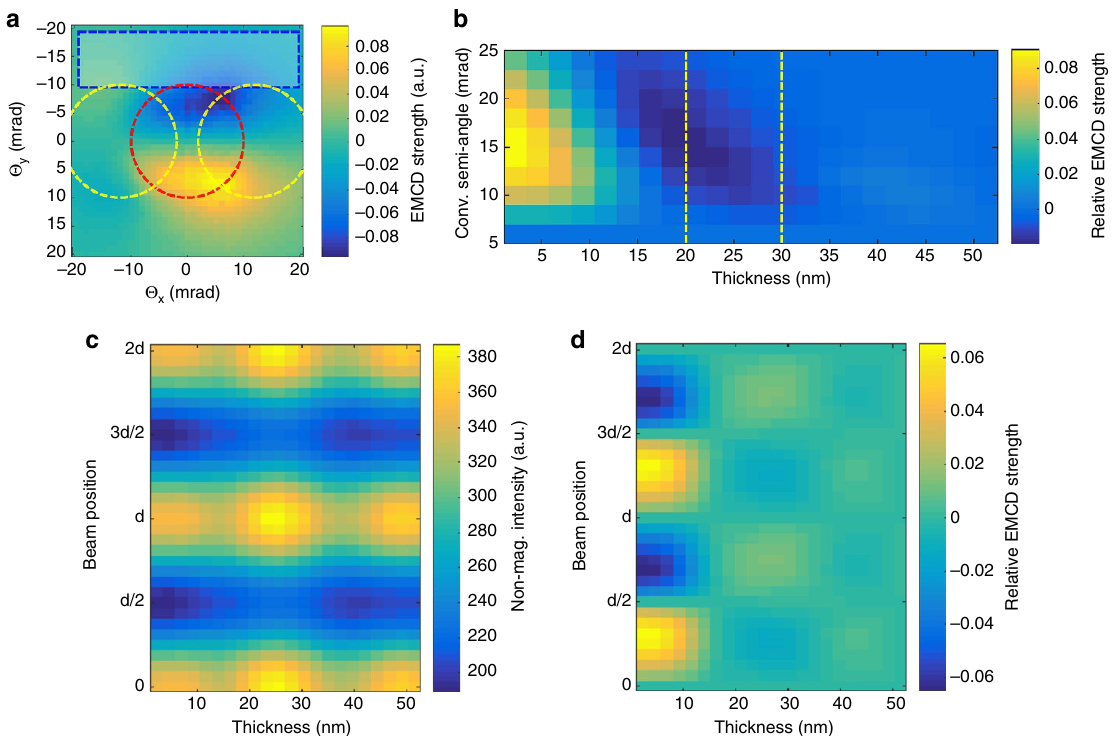
Figure 2 | Simulations of EMCD in the 3-beam geometry. ( a ) Example distribution of the Fe- L 3 edge EMCD signal in the diffraction plane for a beam d 110 ð Þ to the side from atomic planes. Positions of the transmitted beam disk (red circle) and Bragg scattered beam disks (yellow circles) positioned at 1 4 are marked, as well as the rectangular detector region used in ( b ) the optimization of the relative EMCD signal strength as a function of convergence angle and sample thickness. ( c ) Calculated non-magnetic signal as a function of probe position and sample thickness at the Fe- L 3 edge and ( d ) the corresponding relative EMCD strength. In b , c the convergence semi-angle was set to 10mrad.